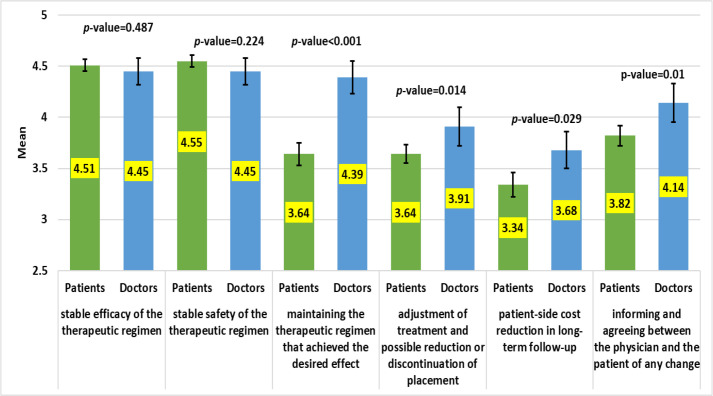
Importance of factors contributing to long-term adherence.Note: p-values from t-tests of the mean difference between doctors and patients’ responses for each dimension.